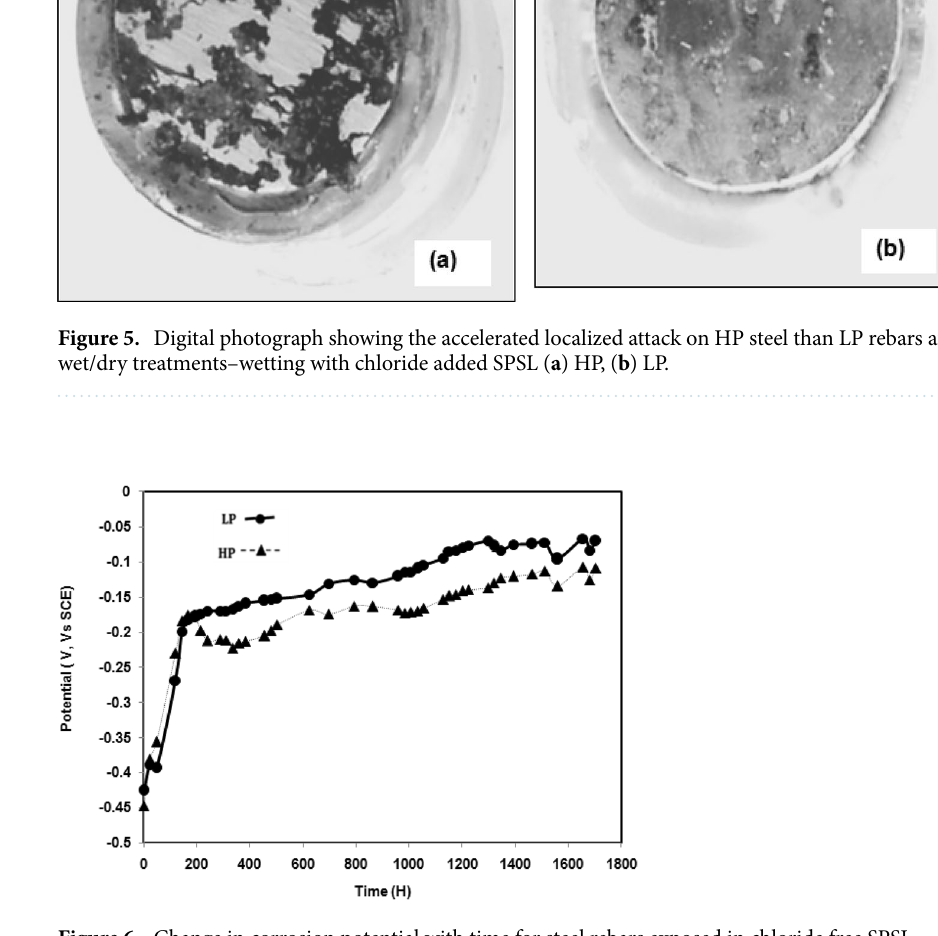
Figure 6. Change in corrosion potential with time for steel rebars exposed in chloride free SPSL.